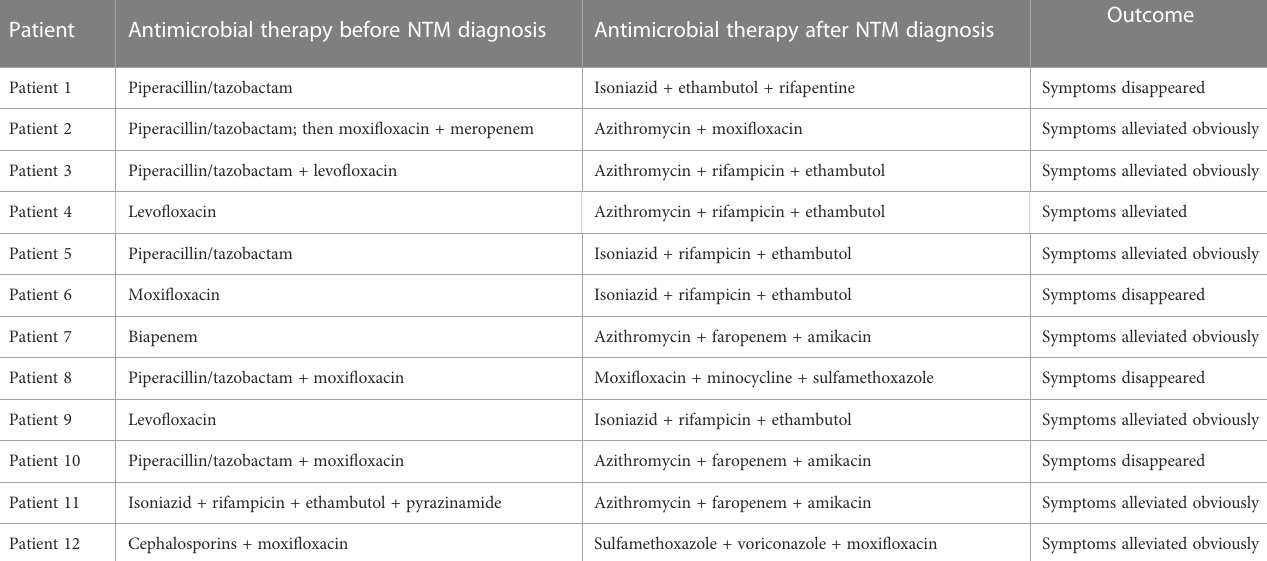
TABLE 6 Treatment and outcomes.